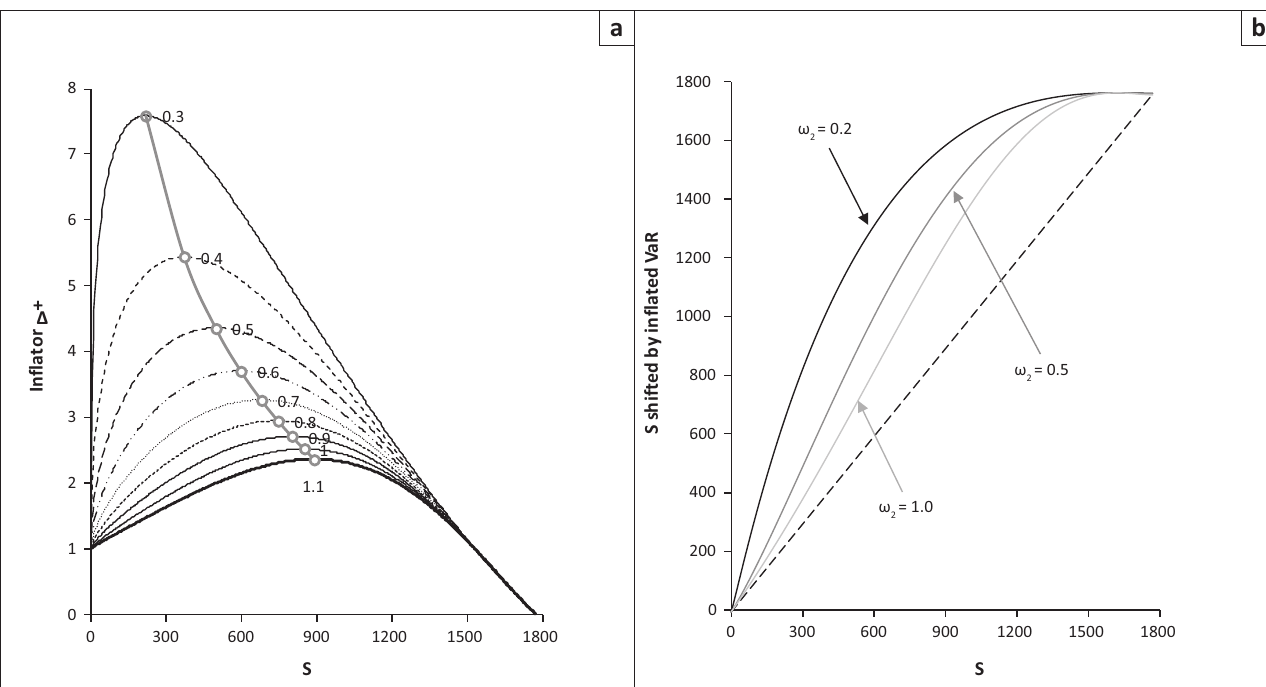
FIGURE 7: (a) The effect of the spread level, S , on ∆ risk for various levels of ω